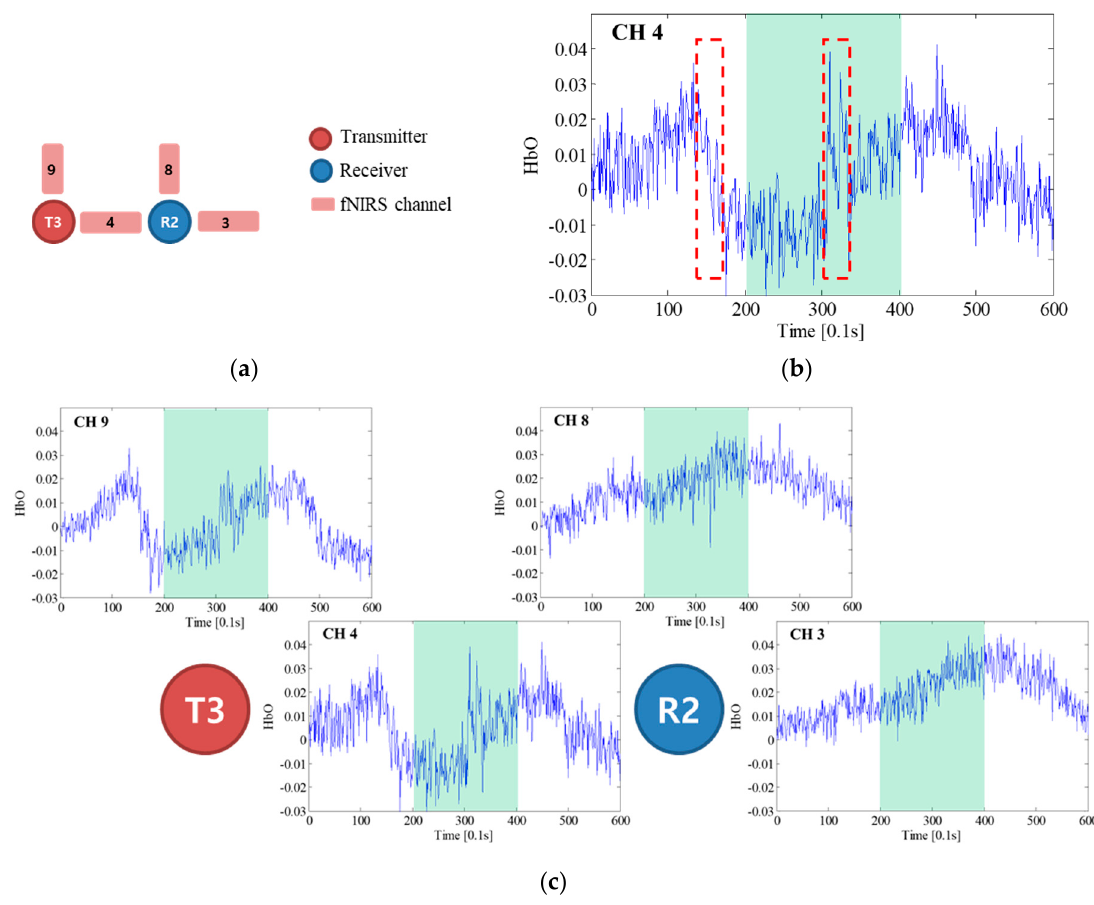
Figure 8. fNIRS signal near optode R2: ( a ) neighbor channels around optode R2; ( b ) fNIRS signal of CH 4; ( c ) fNIRS signals near optode R2 (the green background indicates the task block).